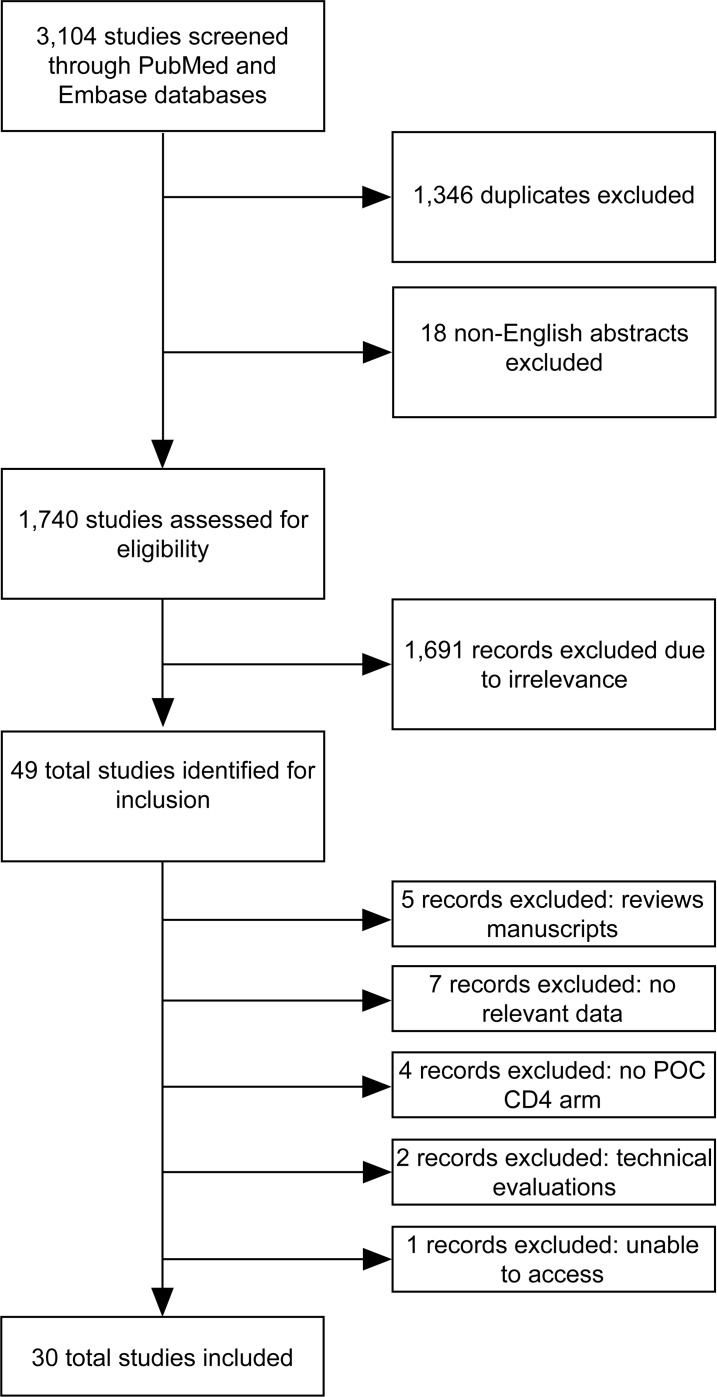
PRISMA diagram of search outcome and included studies.